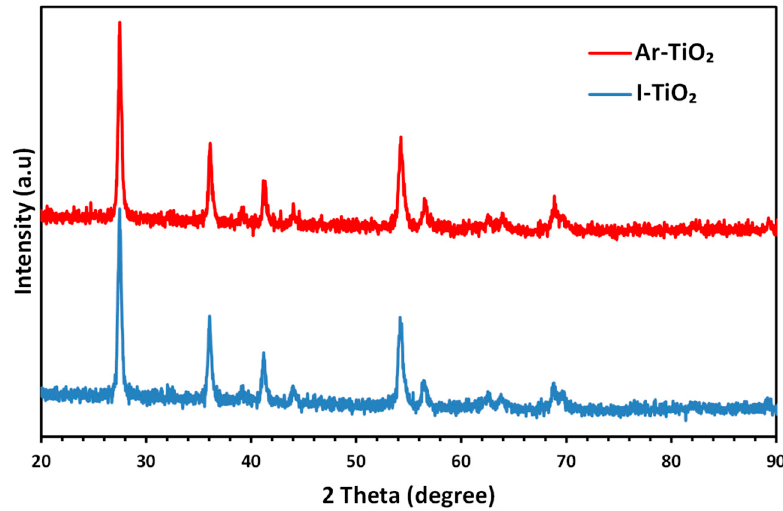
Figure 1. X-Ray diffraction patterns of Ar-TiO 2 and I-TiO 2 samples.